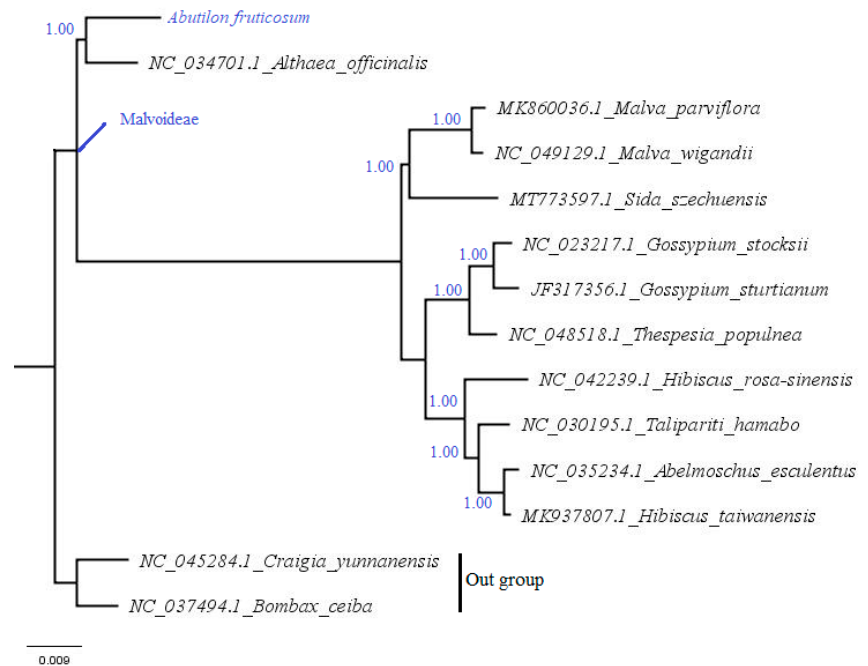
Figure 10. Phylogenetic tree reconstruction of 14 taxa based on the complete chloroplast genomes using the Bayesian inference (BI) method showing relationships within the 14 species of Malvaceae. The numbers in the branch nodes represent posterior probability (PP).